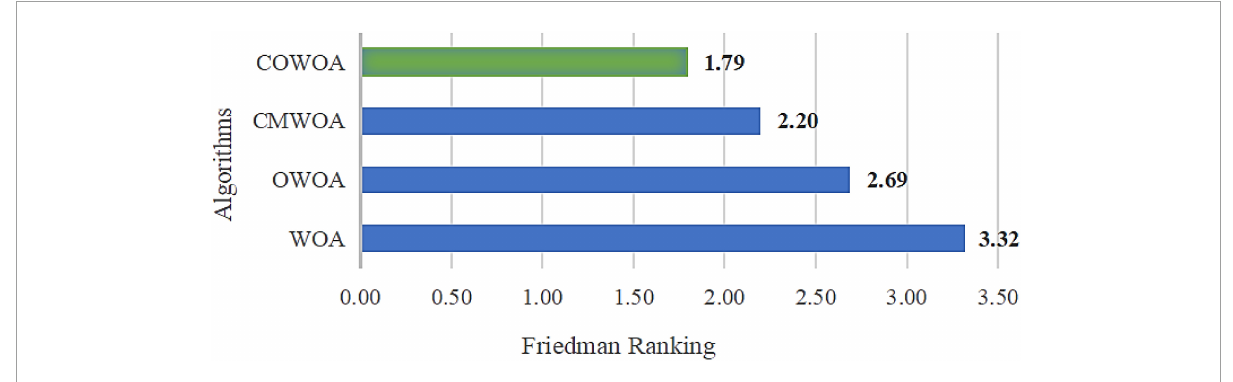
FIGURE4 Results of Friedman ranking between the COWOA optimization